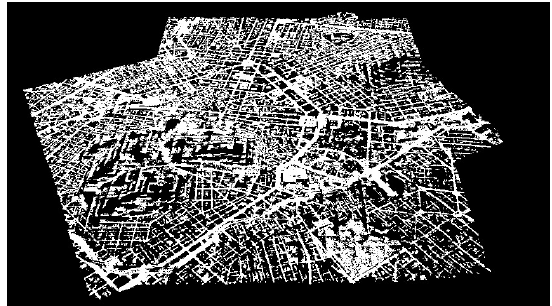
Figure 12: Point cloud including ground-only points